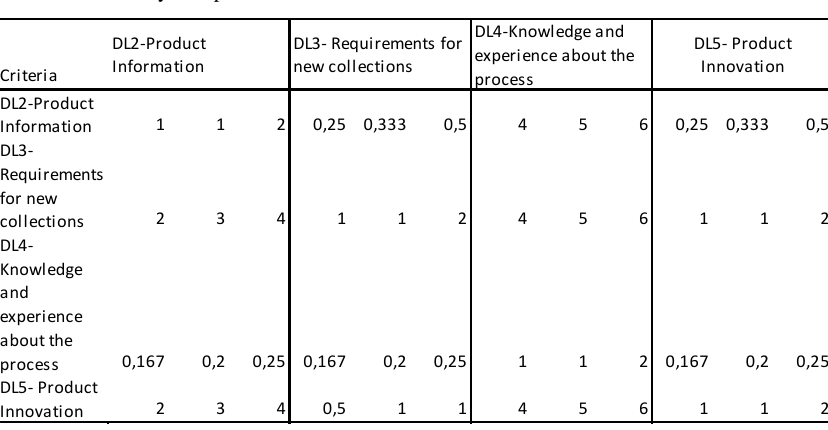
Table 2. The fuzzy comparison matrix over different